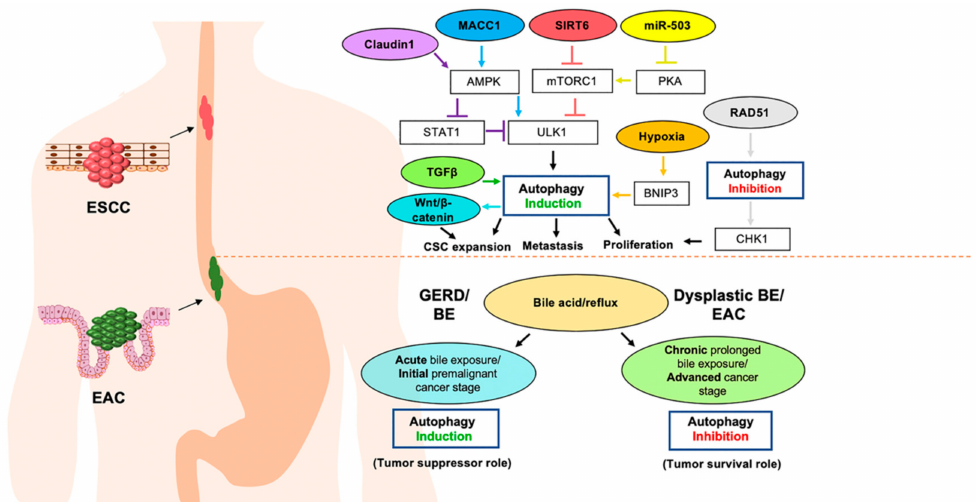
Figure 2. Alterations in autophagy in response esophageal cancer-associated factors. Esophageal squamous cell carcinoma (ESCC) occurs in the proximal portion of the esophagus as esophageal keratinocytes undergo malignant transformation. The schematic above the dotted line depicts how the listed cellular and environmental factors have been demonstrated to impact autophagy in ESCC as well as the e ff ects of autophagy activation and inhibition upon ESCC cells. Esophageal adenocarcinoma (EAC) occurs in the distal portion of the esophagus as esophageal epithelium is displaced by a specialized intestinal metaplasia, Barrett’s esophagus (BE), in response to gastroesophageal reflux disease (GERD). The schematic below the dotted line depicts how bile / acid reflux impacts